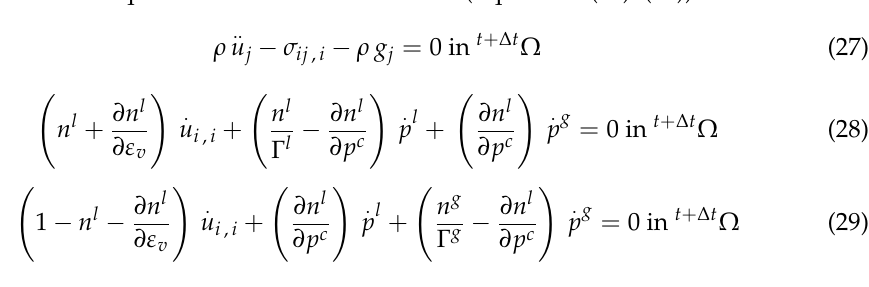
Figure 3. Nodal variables for the ( a ) u-U-U and ( b ) u formulations in 2 dimensions. The final set of equations is summarized below (Equations (27)–(29)).